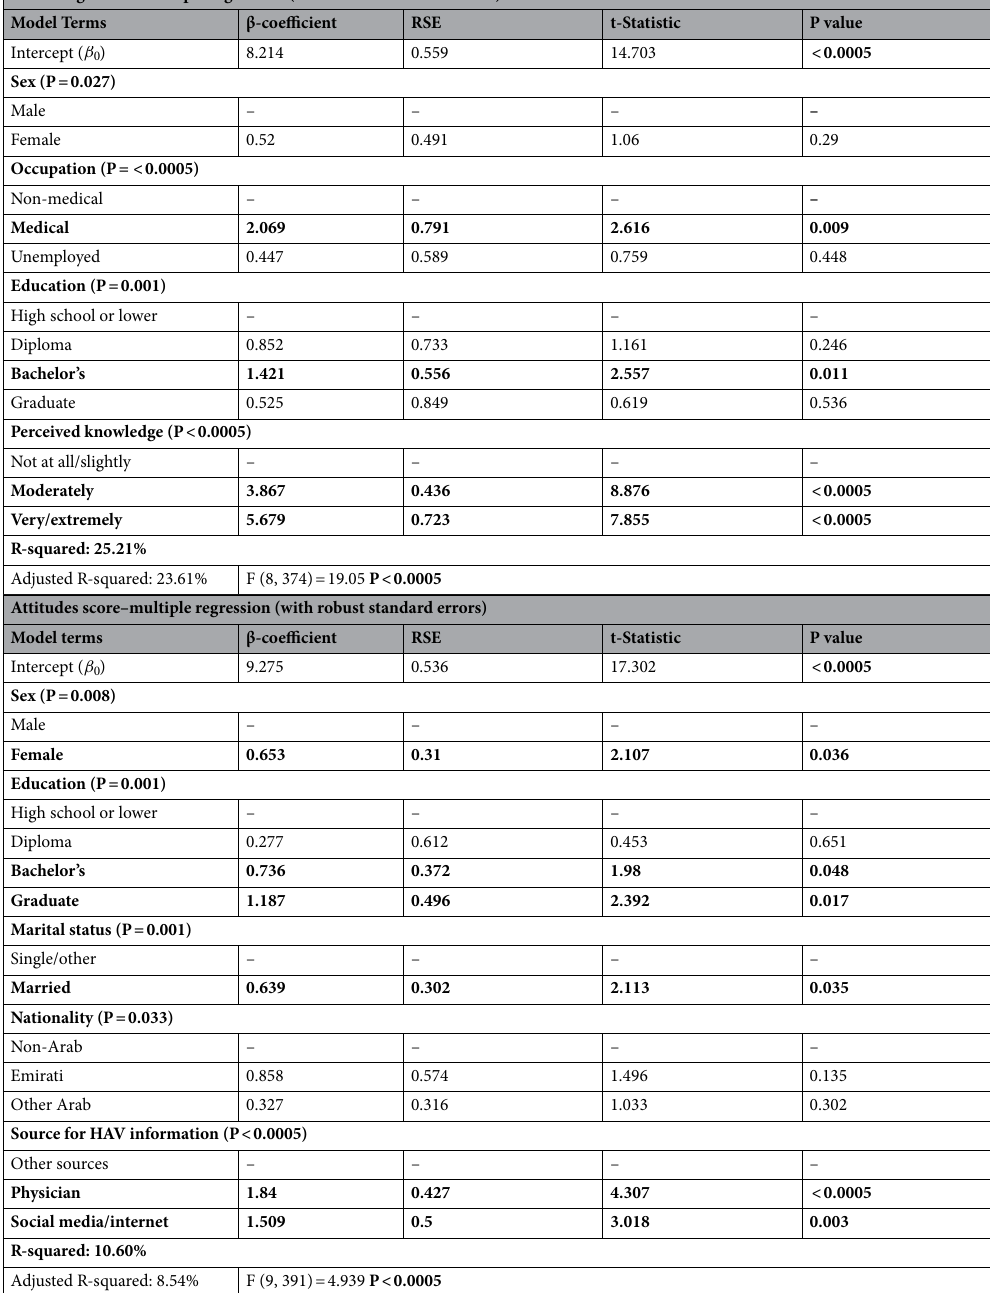
Table 2. Multiple linear regression models - Knowledge and Attitudes. The table represents the results of the knowledge and attitudes multiple linear regression models. P values that are significant at the 5% level are bolded. The significance level of the bivariate analyses is displayed under each predictor. This reflects the P value for the corresponding test with respect to the outcome variable (Mann–Whitney U for binary predictor variables, or Kruskal–Wallis for those with more than two groups). Robust Standard errors were used with an HC1 estimator. The knowledge model contains every significant predictor. For the attitudes model, age and actual knowledge were not included. Both predictors showed high multicollinearity with other features and hence were dropped. RSE robust standard errors, HAV Hepatitis A